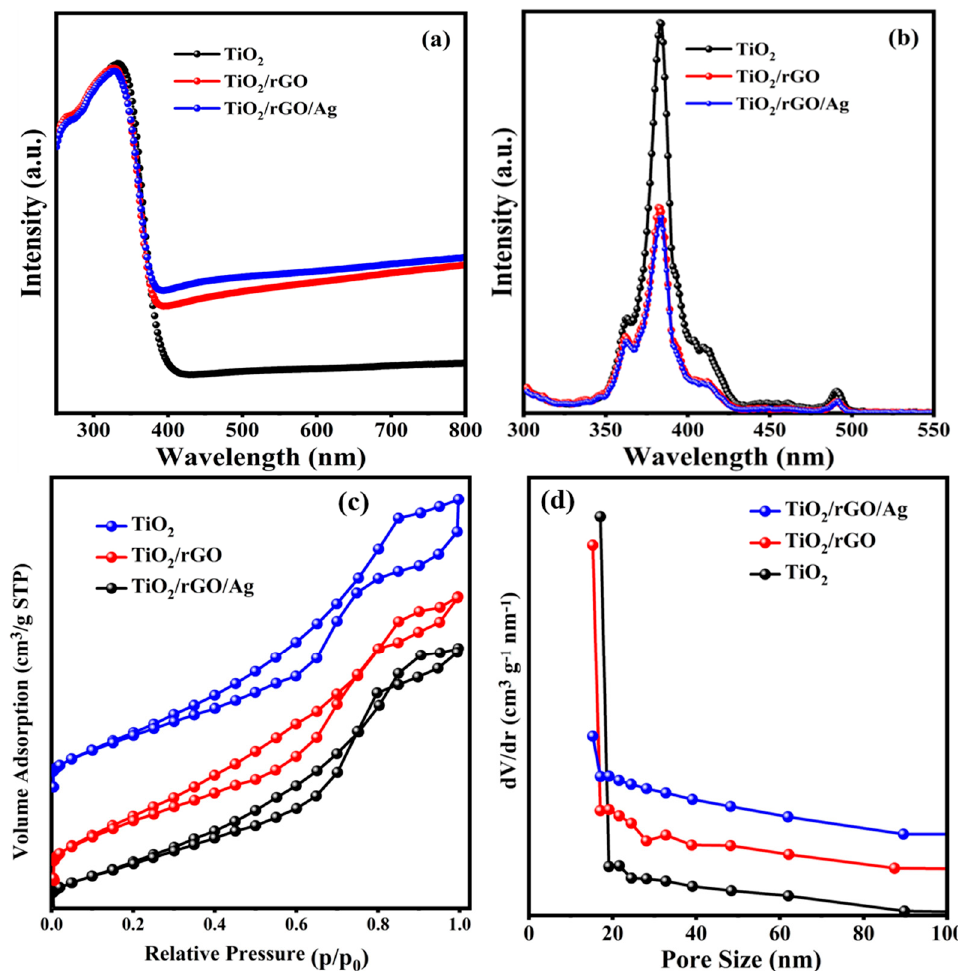
Figure 3. ( a ) UV-DRS absorption spectra, ( b ) PL spectra of mesosphere TiO 2 , TiO 2 /rGO and